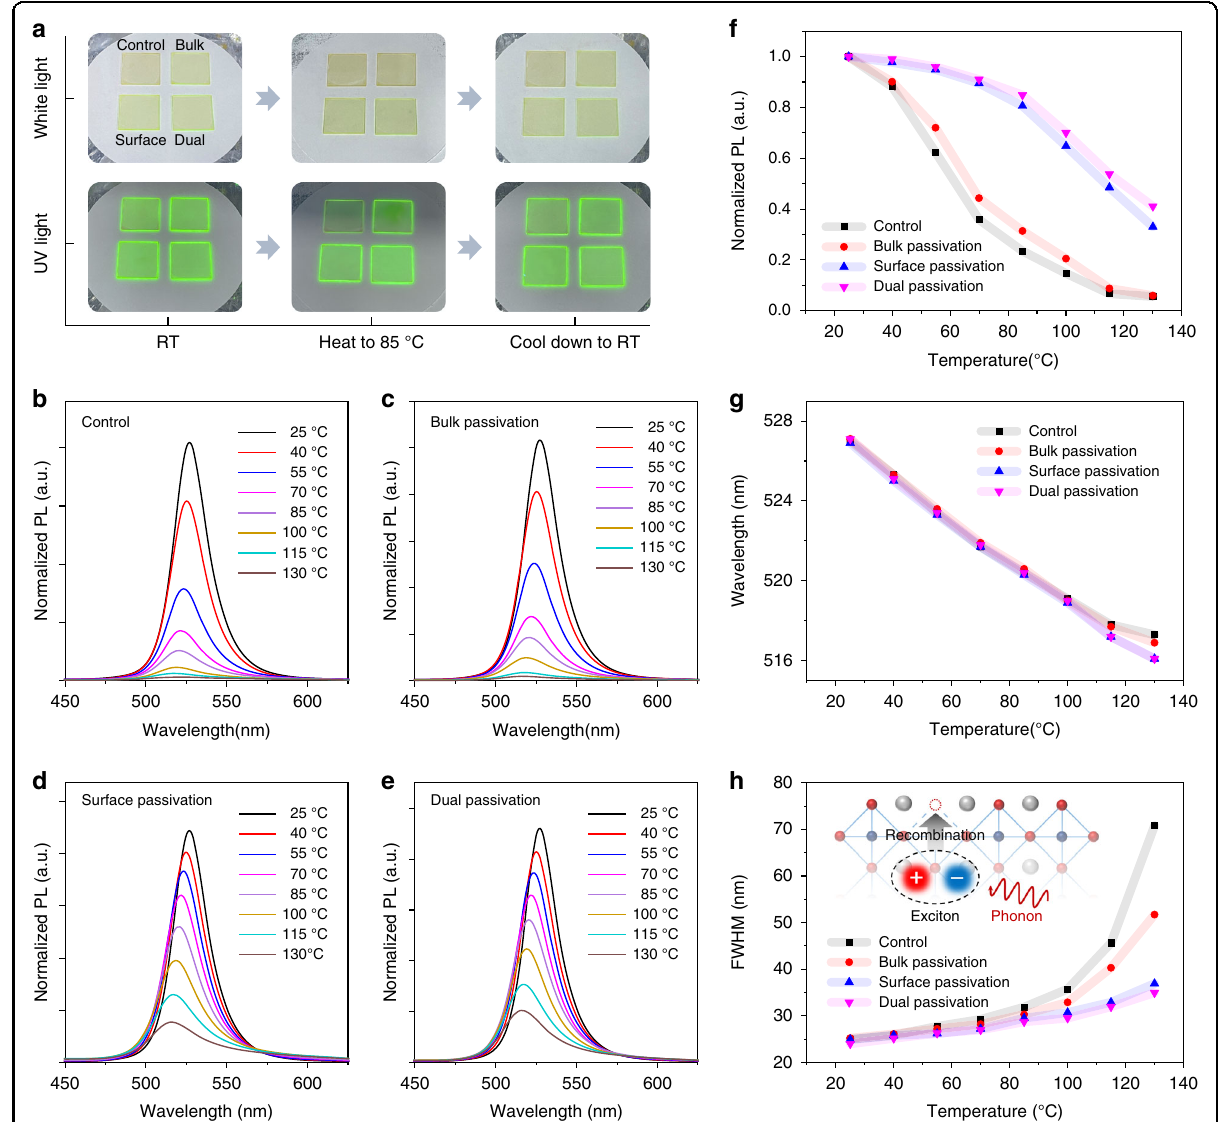
Fig. 5 Impacts of passivation on thermal quenching characteristics of quasi-2D perovskite. a Thermal quenching and recovery processes of quasi-2D perovskite fi lms under white and UV light. Temperature-dependent PL spectra of perovskite fi lms b without, c with bulk, d with surface, and e with dual passivation. f Integrated PL intensities, g wavelength and h FWHM of PL peaks for perovskite fi lms without and with dual passivation. Inset of ( h ) is the diagram of exciton-phonon interaction and nonradiative recombination promoted by